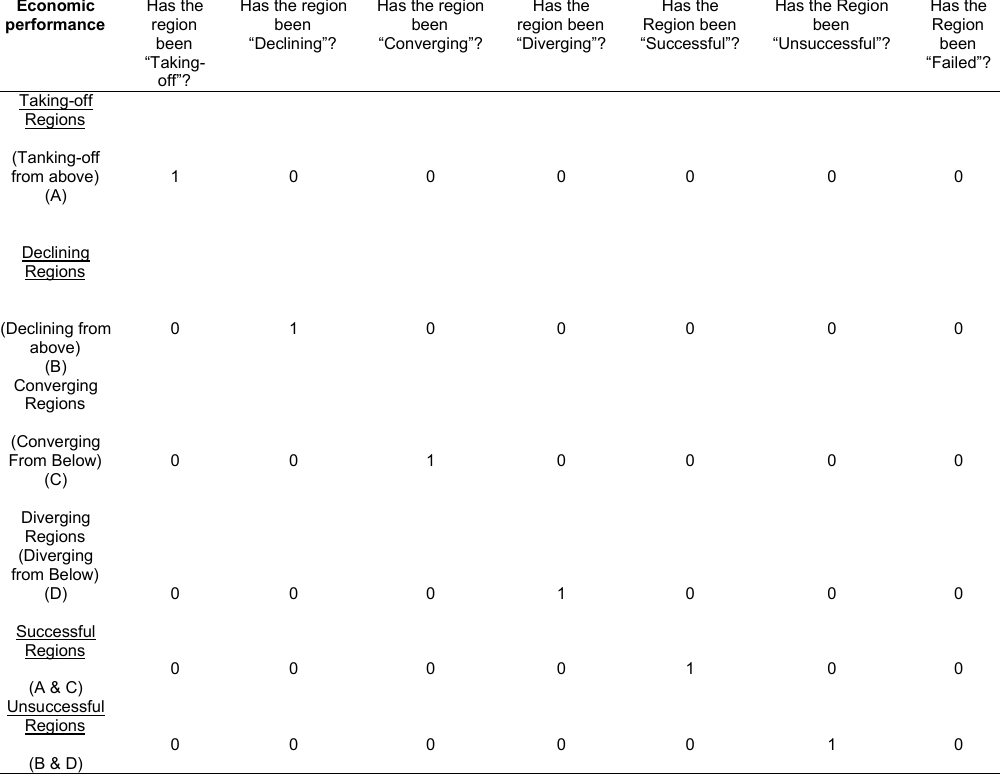
Table 1 . Methodology of construction of binary dependent